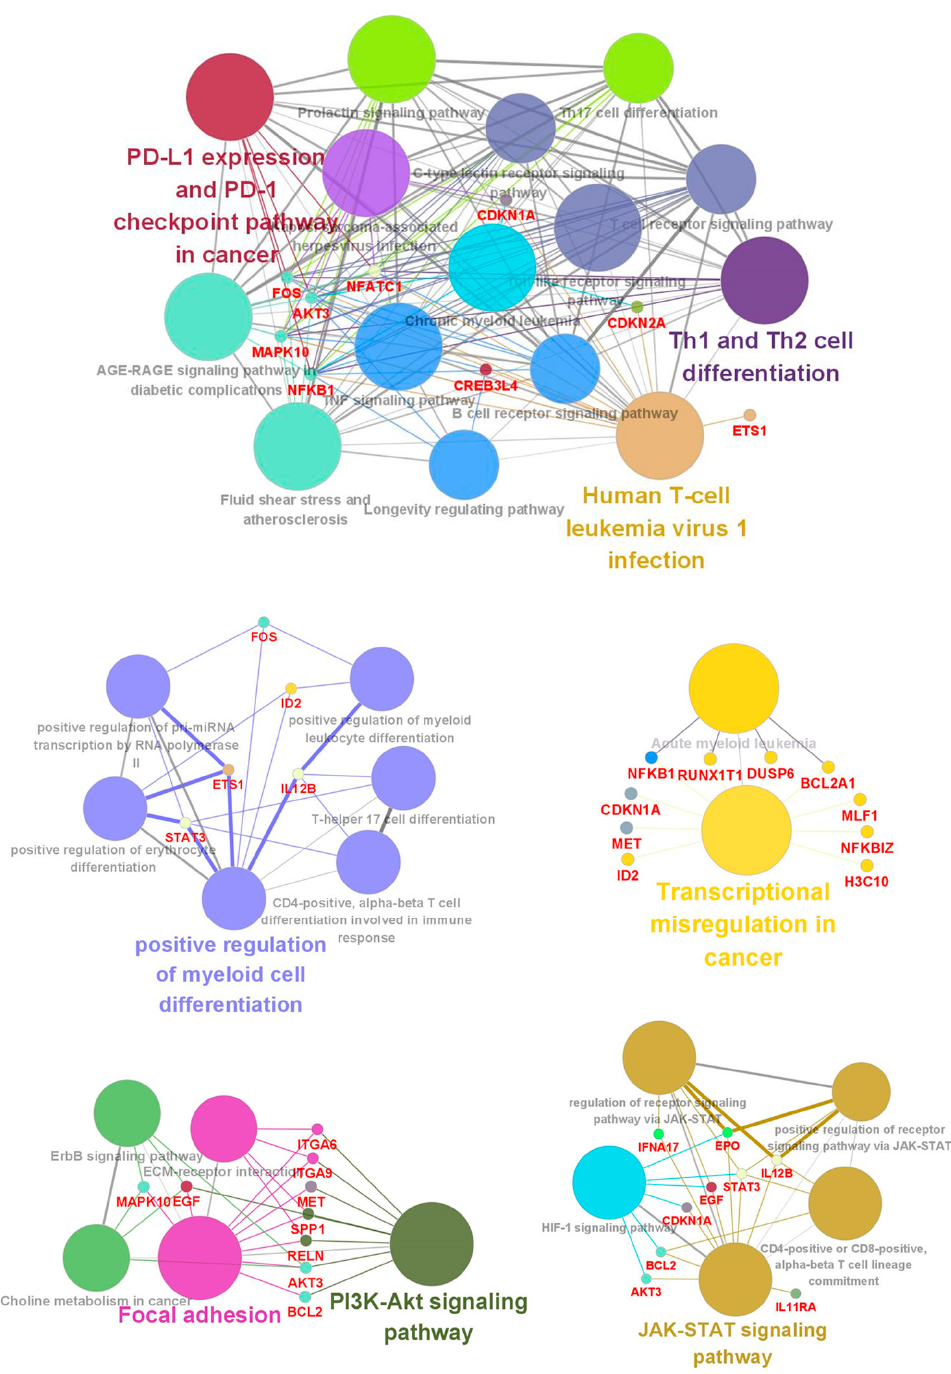
Figure 4. ClueGo analysis-based enrichment maps derived from GO terms associated with DEGs. Highly interconnected GO terms are presented. Terms in bold font indicate top GO terms. Gene names within subgroups were generated using ClueGO default settings. All GO terms shown are statistically significant ( p < 0.05 with Bonferroni correction).